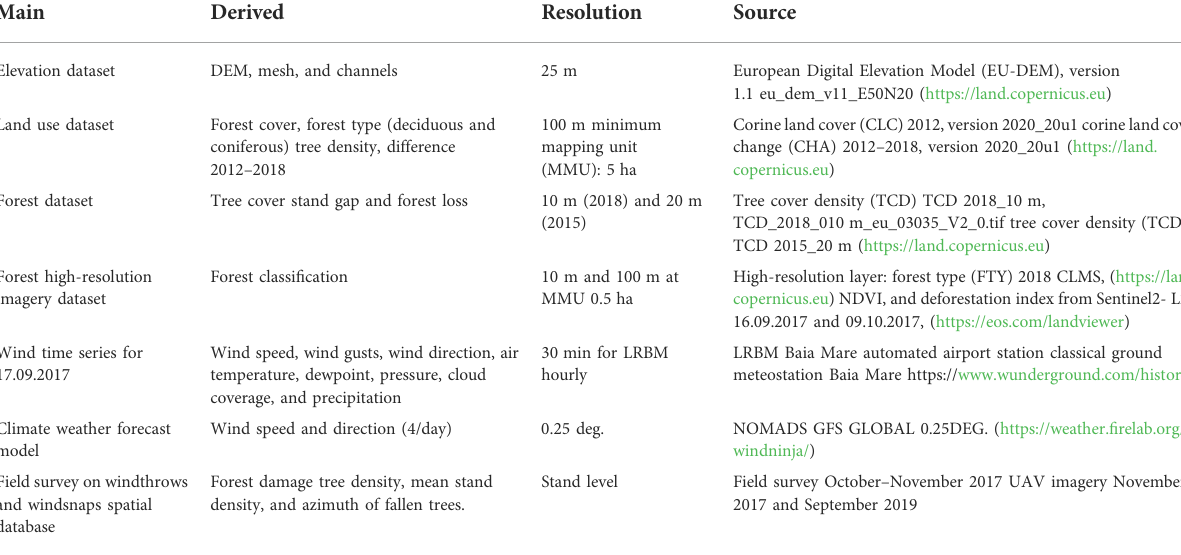
TABLE 2 Data sources for analysis and modeling. Main